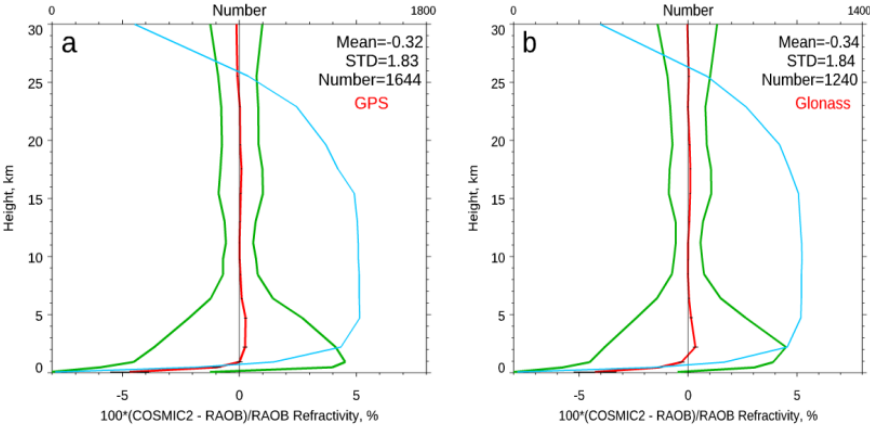
Figure 8. The fractional refractivity comparisons for ( a ) the COSMIC-2/GPS-RS41 pairs, and ( b ) COSMIC-2/GLONASS – RS41 pairs. The mean differences are in the red line, and the standard deviations of the mean difference are in the green line. The sample numbers are in the blue line. The standard errors of the means are in the horizontal black lines superimposed on the mean line. The mean and std values are computed from surface to 30 km altitude.